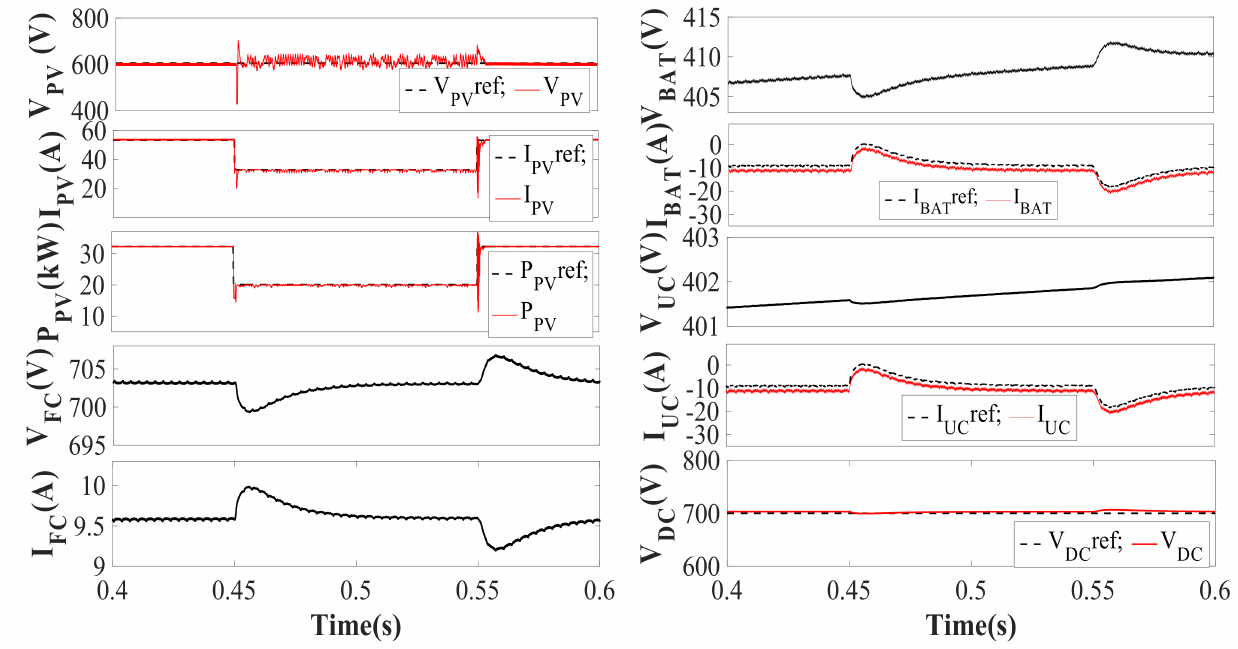
Figure 7. Dynamic performance during insolation variation of V PV , I PV , P PV ,V FC , I FC ,V Bat , I Bat , V UC , I UC , and V DC .